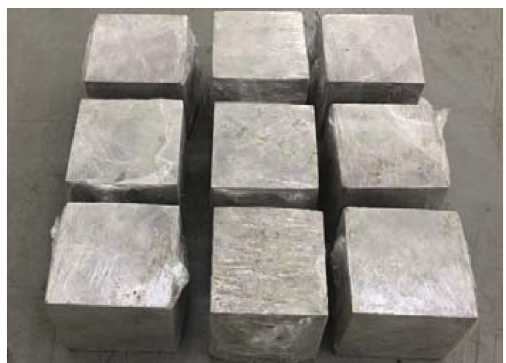
Figure 7: Partial processed sandstone specimens.